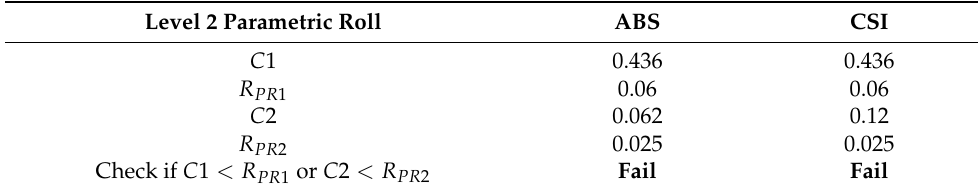
Table 33. Level 2 assessment of parametric roll failure mode for the KCS container ship.